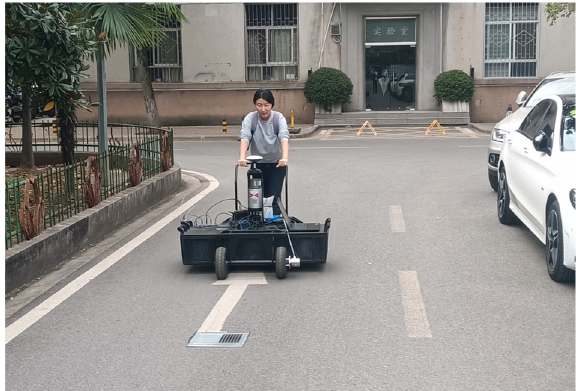
Figure 6. Data acquisition using integrated ground and under- ground surveying